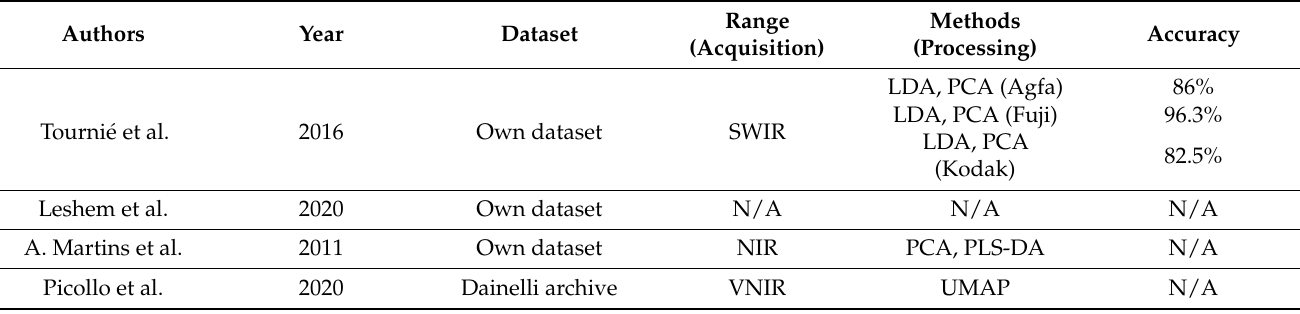
Table 4. Comparison of studies